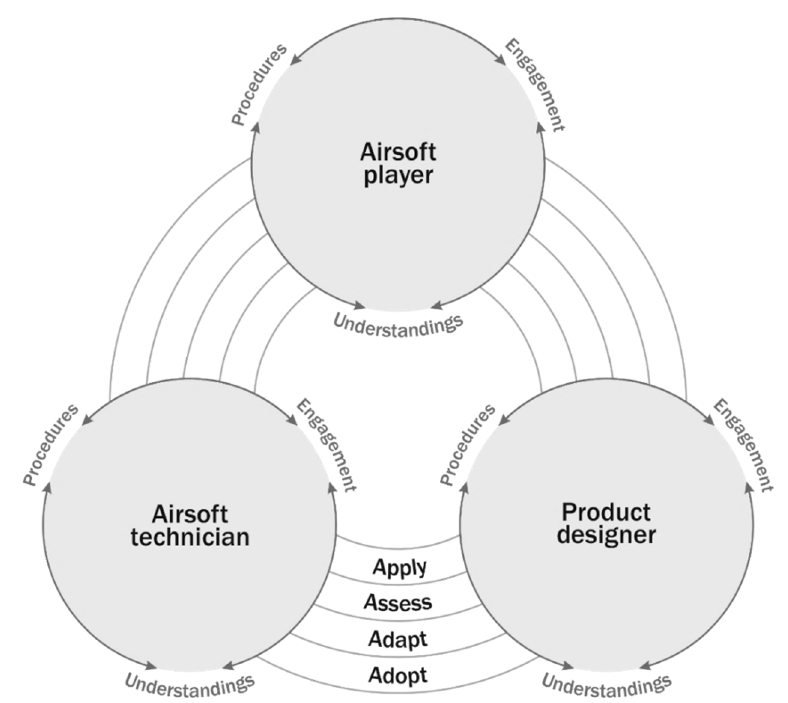
Figure 1. A co-creative practice of forming a value proposition in GATE. Source: own elaboration based on Kowalkowski et al. (2012, p. 1556).